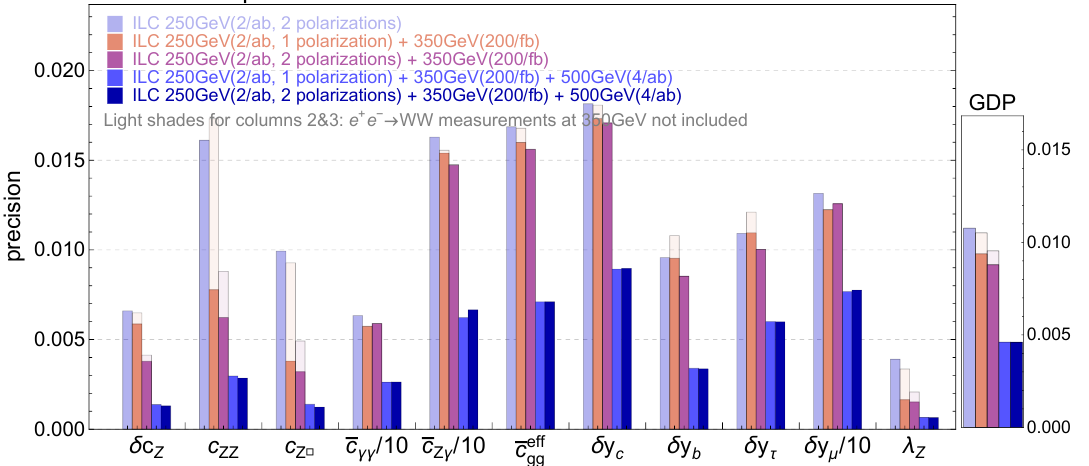
Figure 16 . The precision reach for ILC with di(cid:11)erent scenarios. The 1st column corresponds to the ILC 250 GeV run with 2 ab (cid:0) 1 luminosity which is divided into two runs with